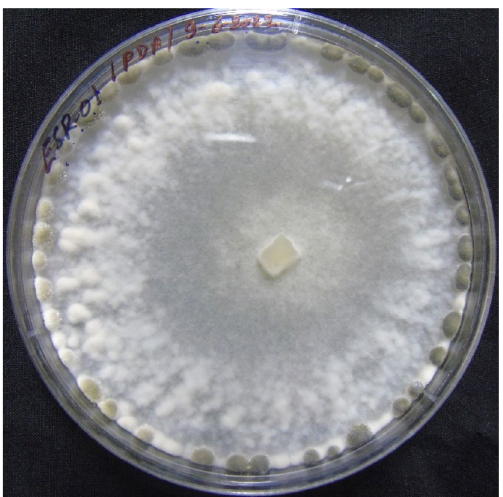
Figure 1. The S. sclerotiorum ‘ESR-01’ isolate from the Brassica juncea field of Rajasthan, India (Long. 77.300° E; Lat. 27.150° N) was used for whole-genome sequencing.